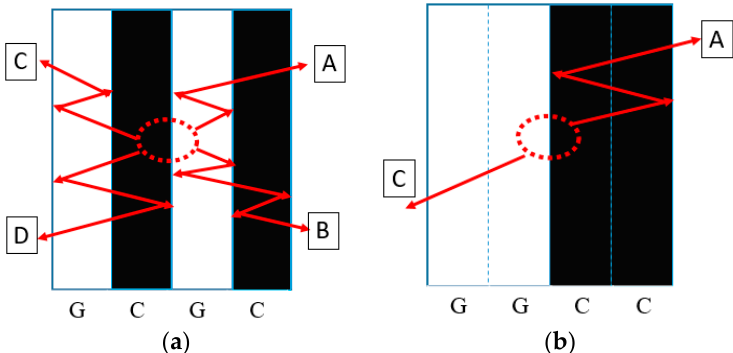
Figure 9. Model of stress wave propagation in intralayer hybrid composite specimens: ( a ) 1:1; ( b ) 2:2.